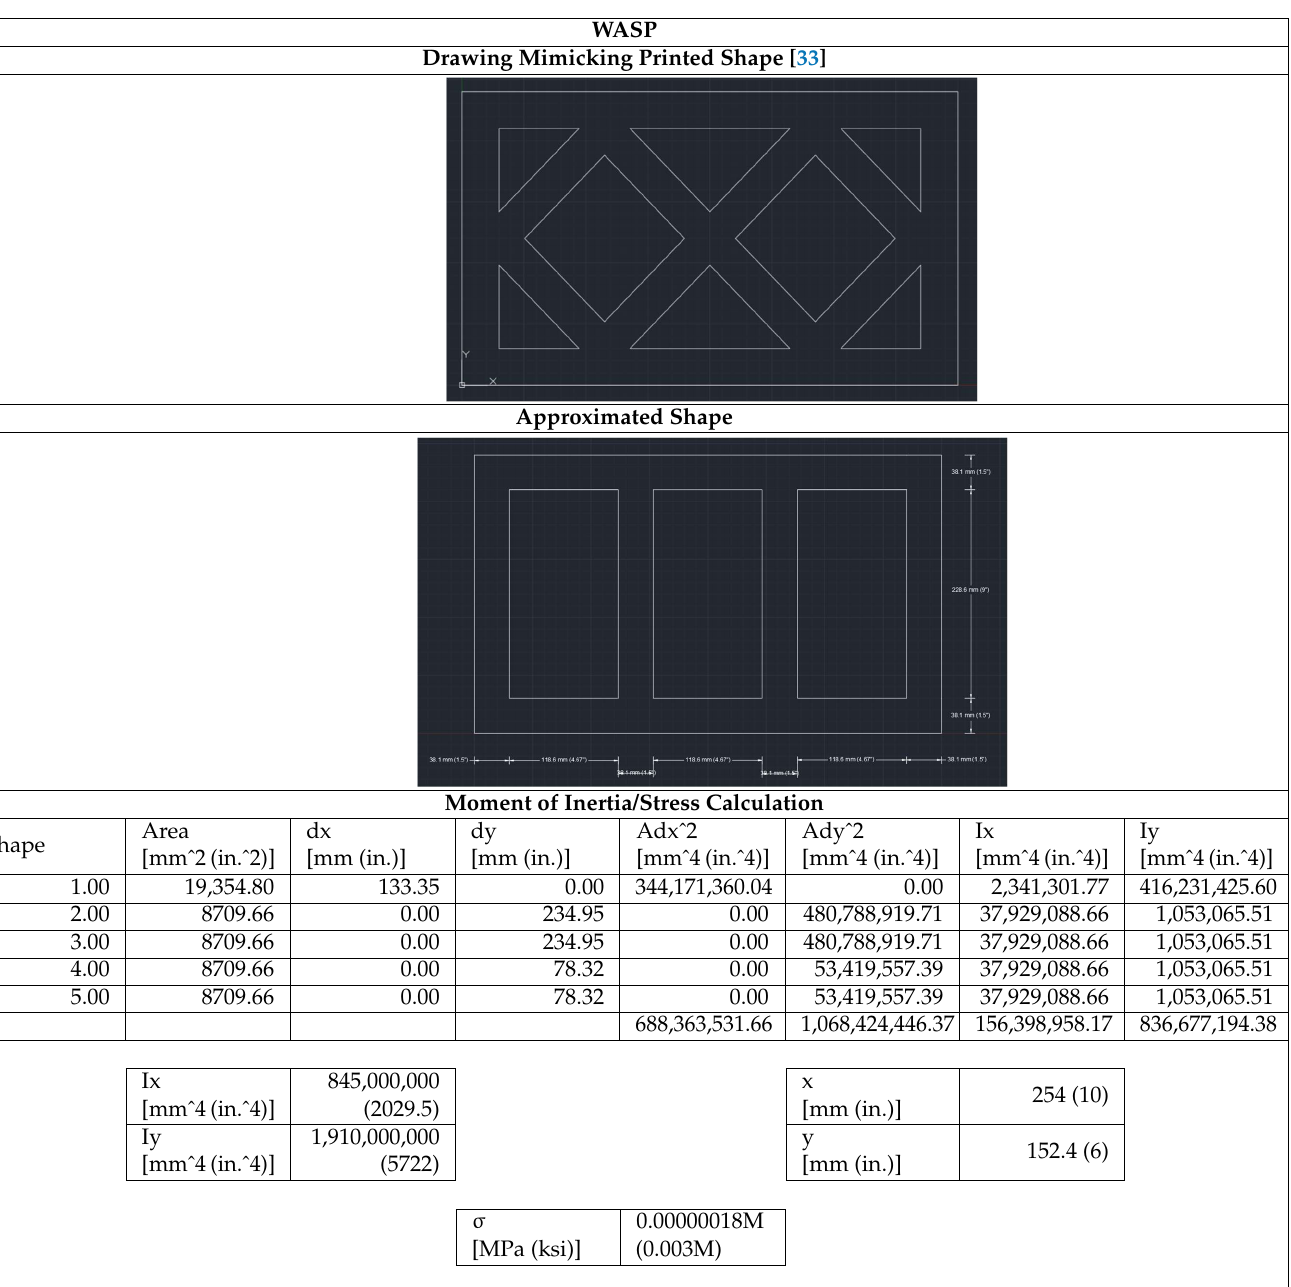
Table A4. WASP wall calculations.